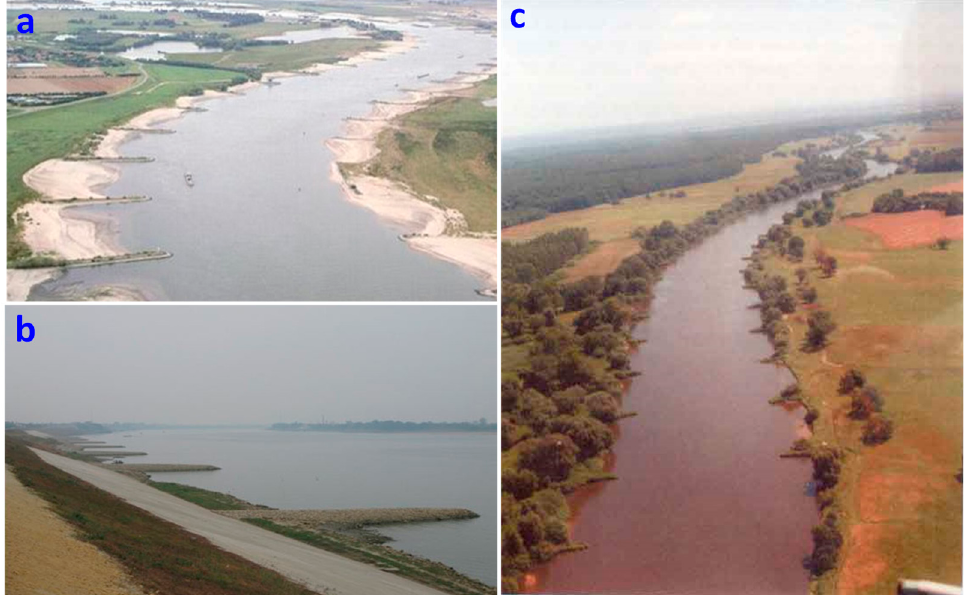
Figure 1. The spur dike groups on river systems (notes: ( a ). Spur dikes to improve both banks of Rhine River, USA; ( b ). Spur dikes to reinforce banks of Xijiang River, Guangdong, China; ( c ). Spur dikes as training works for navigation in Odra River, Poland).